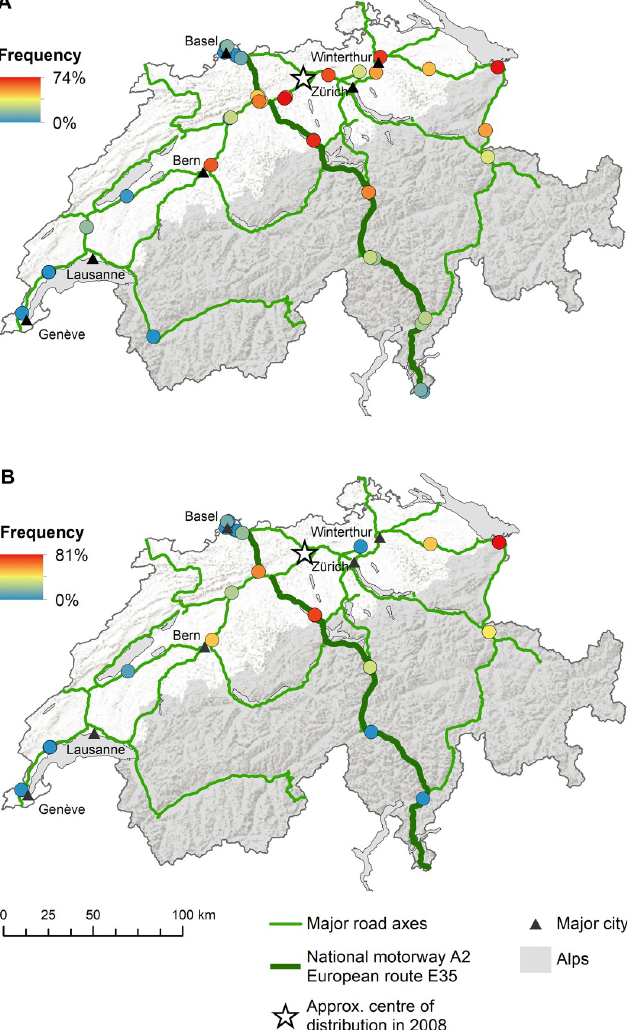
Fig 4. Frequency of Aedes japonicus positive sites along the Swiss main traffic axes. ( A) Map showing the frequency of positive ovitraps per site. Each dot represents a site while the colour indicates how often the site was positive for Ae . japonicus between 2013 and 2018. Missing slats were excluded from the analysis. ( B) Map showing the frequency of positive BG-Sentinel traps per site. Each dot represents a site while the colour indicates how often the site was positive for Ae . japonicus between 2014 and 2018. Missing BG-Sentinel traps were excluded from the analysis. Map source: Swiss Federal Office of Topography (swisstopo); Swiss Federal Statistical Office, Section Geoinformation (GEOSTAT) and Swiss Federal Office for Spatial Development